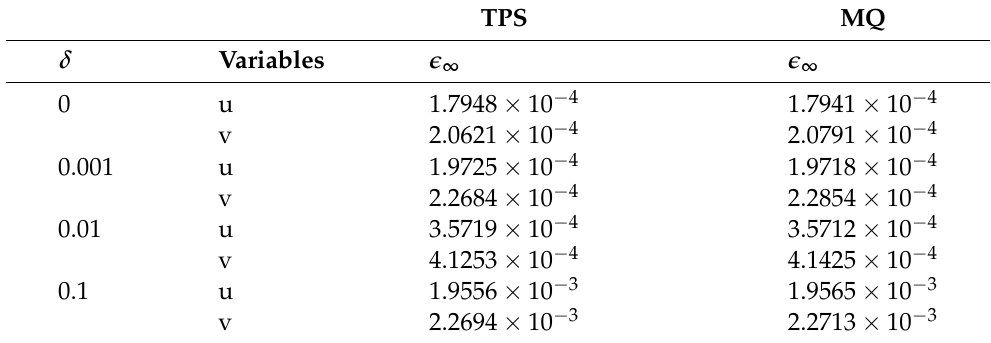
Table 6. The effect of noise on error estimates of Example 2 for N = 1862, τ = 0.5 ( dx ) 2 , and n c =